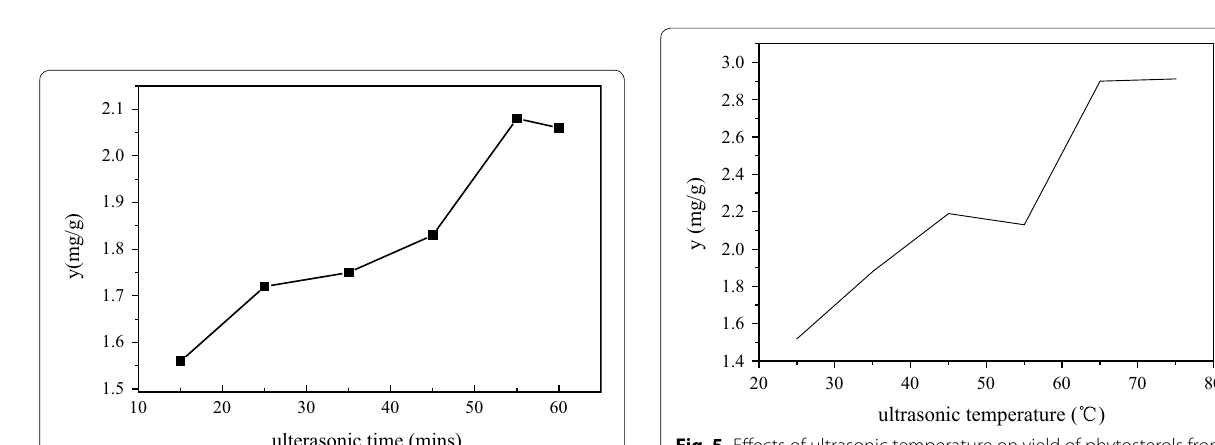
Fig. 5 Effects of ultrasonic temperature on yield of phytosterols from